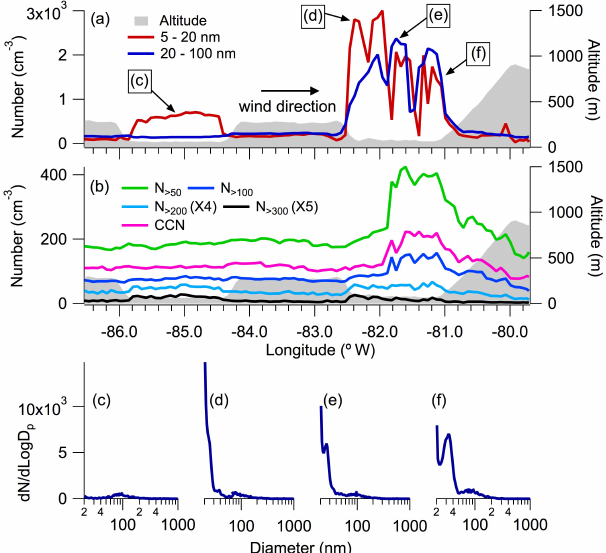
Figure 4. (a) Aircraft altitude (grey) and particle number concen- trations from 5–20nm ( N 5–20 , red) and 20–100nm (integrated SMS concentration, N 20–100 , dark blue), both shown at the time resolu- tion of the SMS, over the case study area highlighted in Fig. 2a. (b) Particle number concentrations greater than 50nm ( N > 50 , light green), greater than 100nm ( N > 100 , dark blue), greater than 200nm ( N > 200 , light blue, multiplied by 4), greater than 300nm ( N > 300 , black, multiplied by 5) and CCN concentrations at 0.6% supersat- uration (pink) shown at the time resolution of the SMS. Particle- number size distributions from 20 to 1000nm (from the SMS and UHSAS) at (c) 85.1 ◦ W, (d) 82.3 ◦ W, (e) 81.8 ◦ W and (f) 81.1 ◦